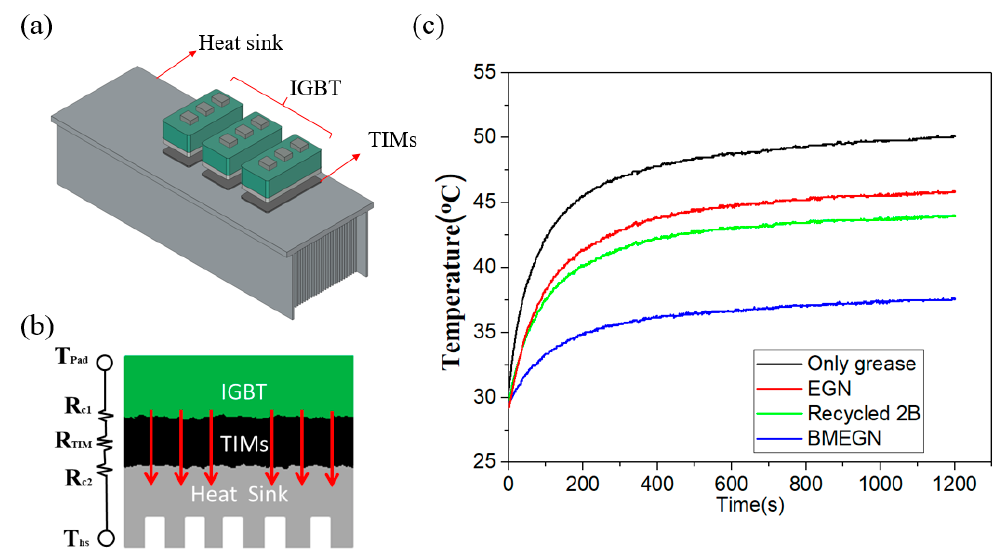
Figure 9. ( a ) Schematic setup of the heat dissipation test, showing three TIMs sandwiched between the IGBT chips and aluminum heat sink; ( b ) thermal resistance network; ( c ) temperature measurements of heat dissipation tests of EGN, recycled 2B and BMEGN composites.